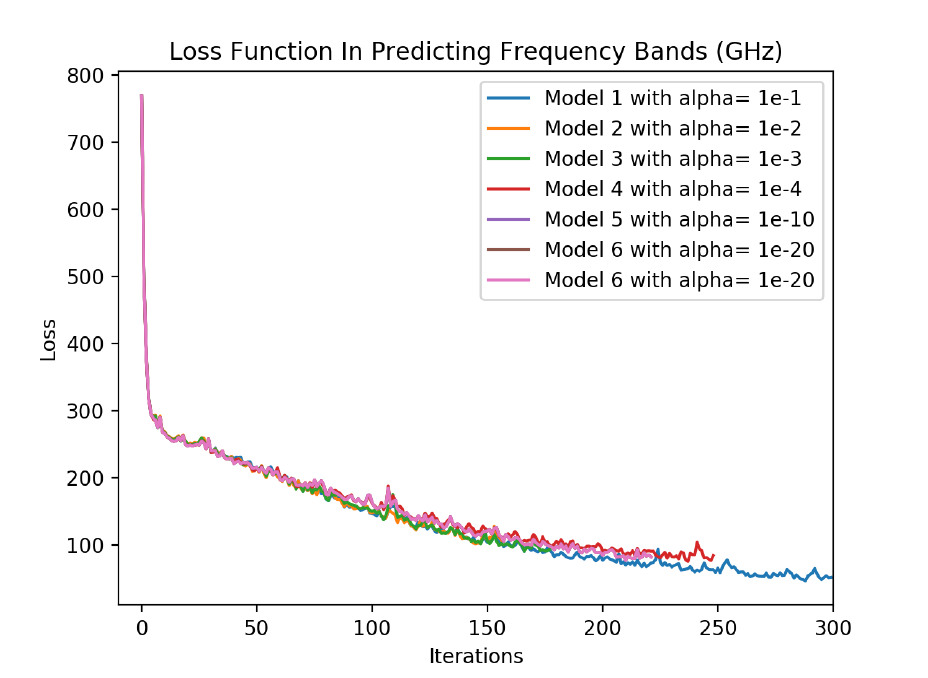
Figure 7. The loss of the proposed